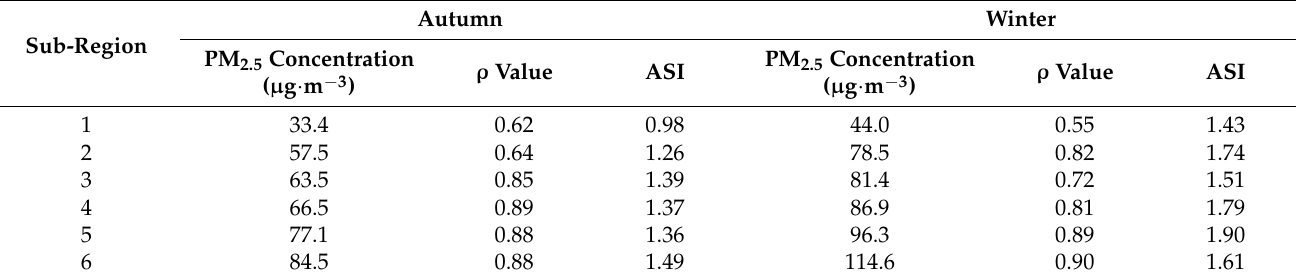
Figure 11. Clustering results based on Euclidean distance for average daily PM 2.5 concentrations ( a , c ) and daily air stagnation index (ASI) ( b , d ) in autumn 2018. Table 1. Mean of PM 2.5 concentrations, ρ value, and ASI for cluster sub-regions based Euclidian distance in autumn and winter 2018,